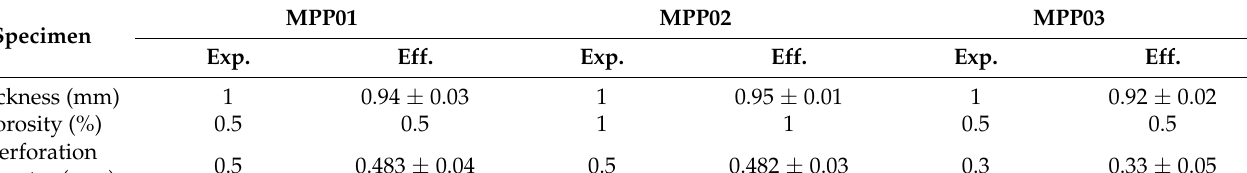
Table 3. Expected (exp.) and effective (eff.) geometrical parameters of the three MPP specimens.